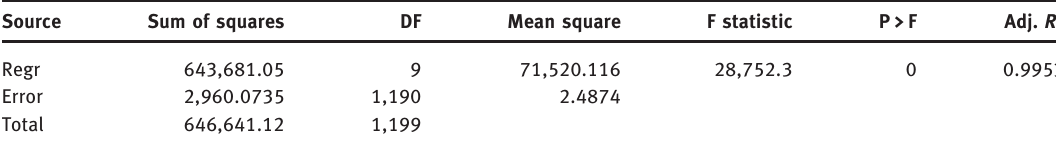
Table 4: Analysis of variance for f 1 ð _ ε , T Þ at medium temperature with the strain of 0.002. Source Sum of